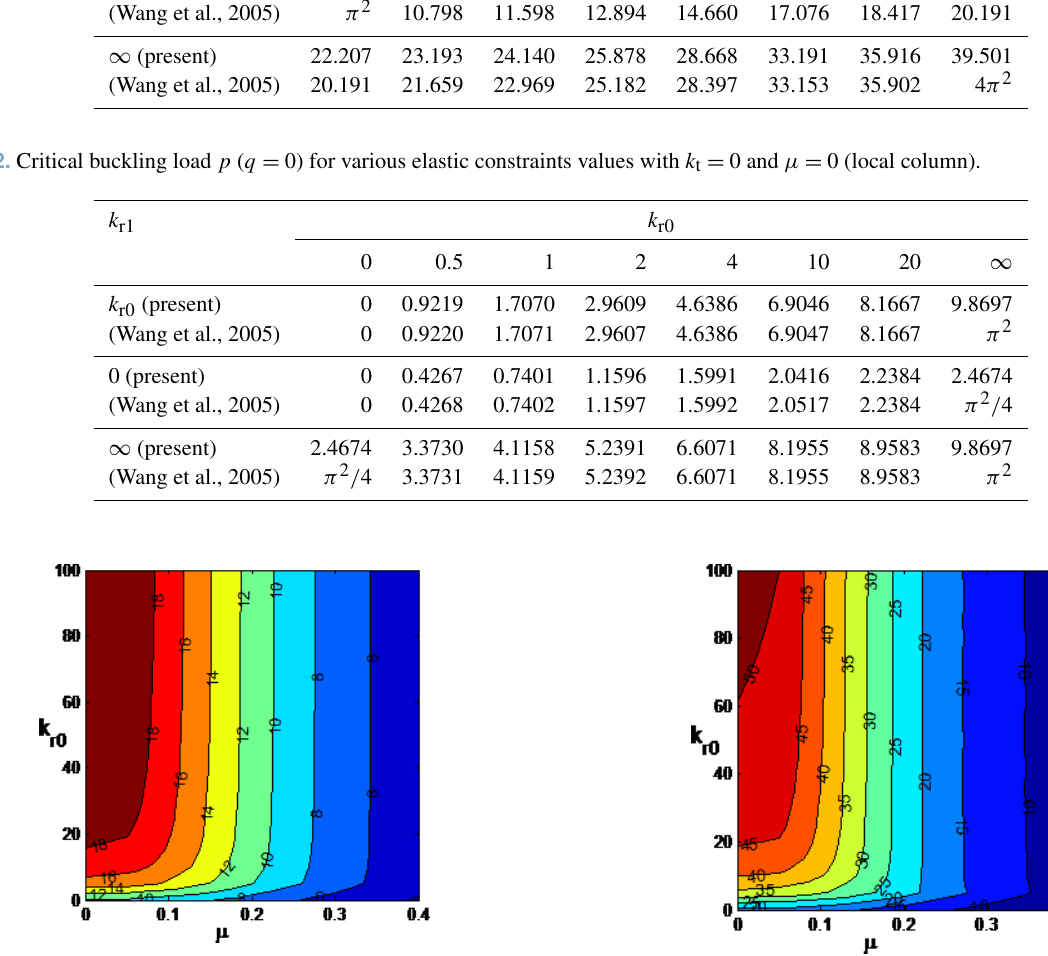
tain value of k r0 depending on the small scale parameter µ .